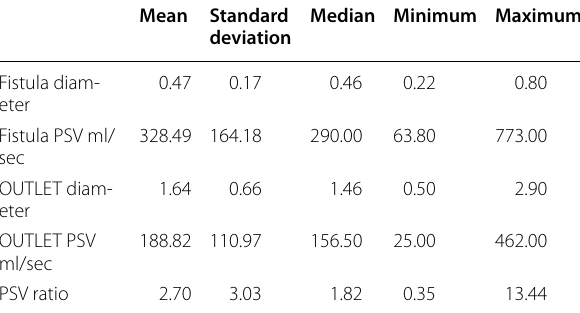
Table 2 CDU examination parameters in the study group